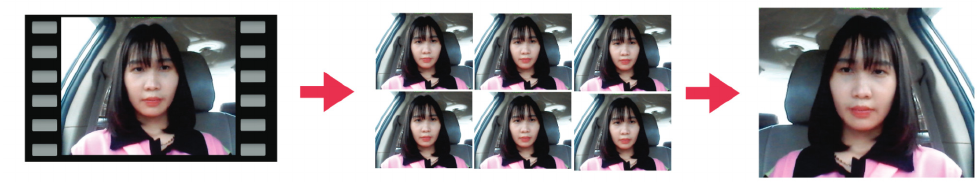
Figure 7. Illustration of extracting image frames from input videos.